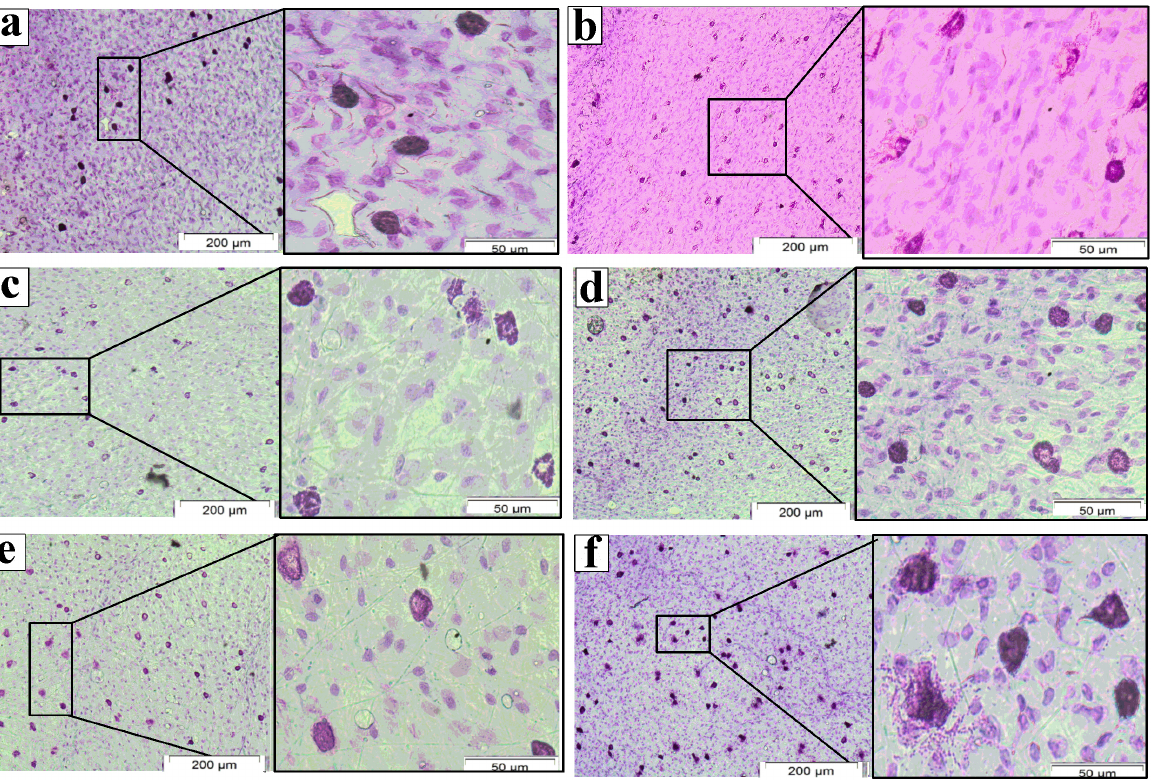
Figure 5 - Representative microphotography of the effect of the NST (50, 100 and 200 mg/kg, i.p.), vehicle (0.9% NaCl + 5% Tween 80, i.p.) and cetotiphen (2 mg/kg, i.p.) on ex vivo compound 48/80-induced mast cell degranulation in rats. Mast cells from rats treated with only vehicle (a) , and treated with vehicle following the incubation with compound 48/80 (0.4 µg/mL) (b) , exhibiting extensive mast cell degranulation. Mast cells from rats incubated with compound 48/80 and previously treated with the NST at doses of 50 (c) , 100 mg/kg (d) and 200 mg/kg (e) , and cetotiphen (2 mg/kg) (f) , showing inhibition of degranulation at the magnifications of 10× and